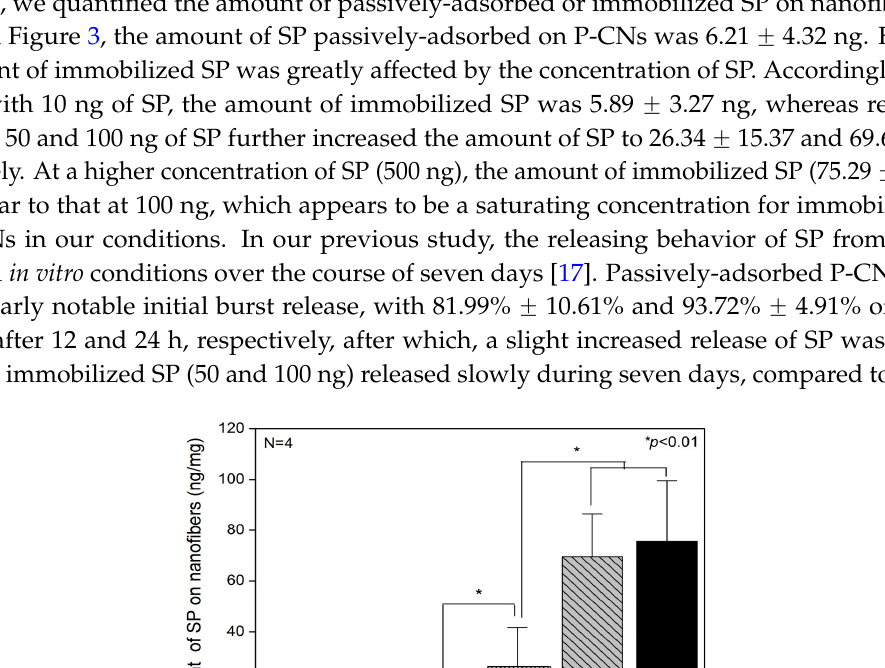
Figure 2. Average fiber diameters of CNs. The average diameter of nanofibers was determined by selecting 10 fields from each image and manually measuring fiber diameters.